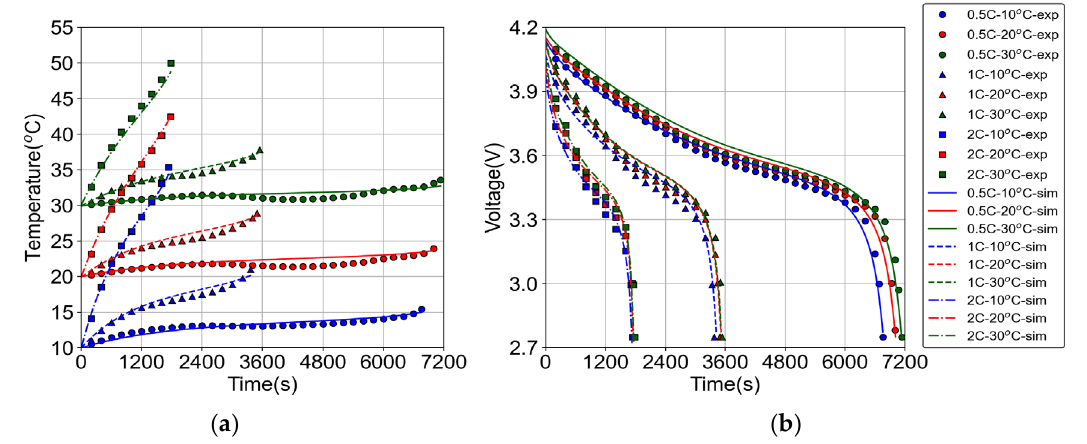
Figure 9. The verification of single battery under different discharge rate and different ambient temperature. ( a ) Temperature increase; ( b ) terminal voltage.